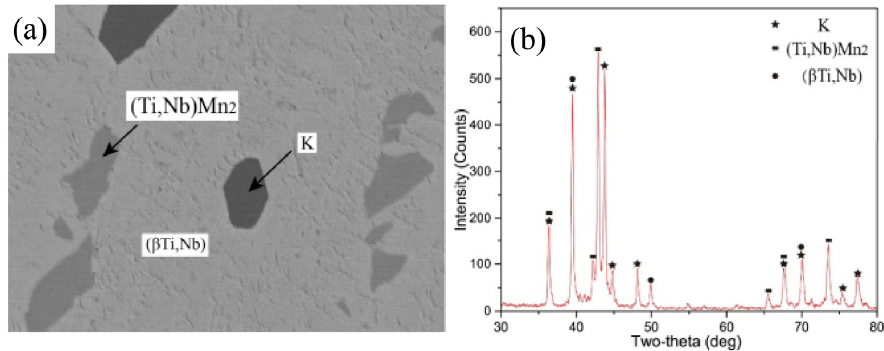
According to the microstructure results in Figures 14a and 15a, the alloy B6 consists of three phases: ( β Ti,Nb) (white base phase), (Ti,Nb)Mn 2 (light gray phase) and the K phase (dark gray phase); the alloy B9 is composed of β TiMn (white phase), the K-Ti 50 Nb 7 Mn 43 phase (gray striped phase) and ( β Ti,Nb) (black phase). In Figures 14b and 15b, after the characteristic peaks of the other two phases were matched, the remaining diffraction peaks can be well matched with the previously obtained unknown ternary phase K-Ti 50 Nb 7 Mn 43 . Thus, the existence of K-Ti 50 Nb 7 Mn 43 can be determined.